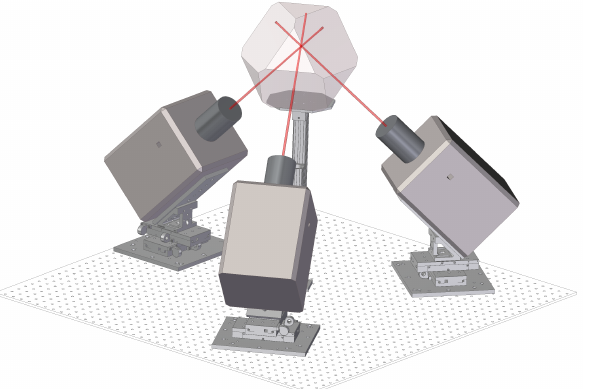
Figure 2. Experimental setup. Three orthogonal high-speed cameras focused on a transparent chamber. The non-Cartesian setup reduces wing occlusions.